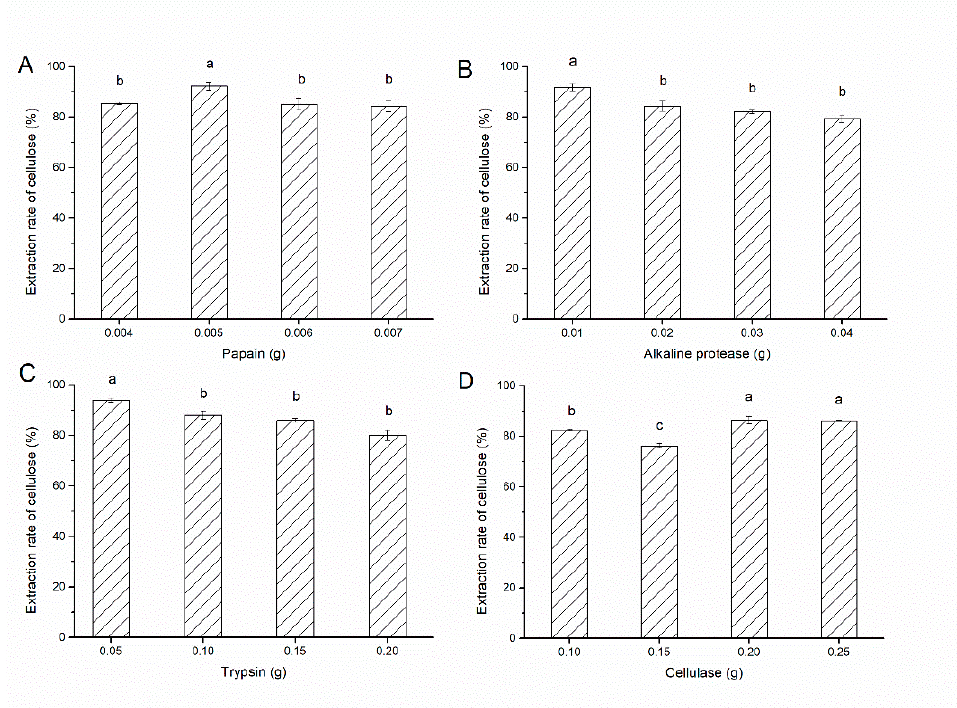
Figure 1. The effects of adding different proteases on the extraction of cellulose. ( A ) The effect of papain addition on the extraction of cellulose. ( B ) The effect of alkaline protease addition on the extraction of cellulose. ( C ) The effect of trypsin addition on the extraction of cellulose. ( D ) The effect of cellulase addition on the extraction of cellulose.